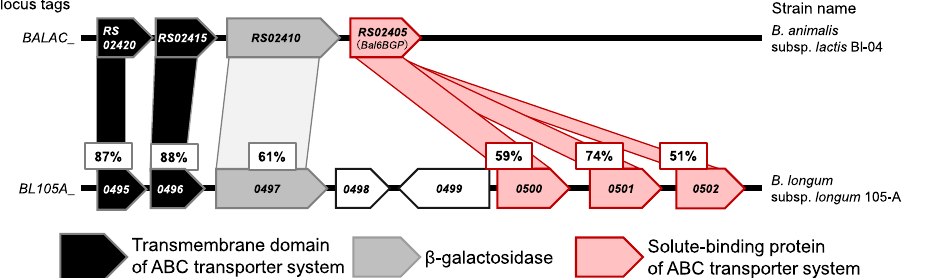
Fig. 1 Comparison of the genomic structure of B. animalis subsp. lactis Bl-04 at the Bal6 BGP locus with the corresponding region of B. longum subsp. longum 105-A. Solid arrows indicate open reading frames (ORFs) with their lengths proportional to the polypeptide chain lengths. The locus tag numbers are indicated inside the arrows. The amino acid identity (%) between the homologues is shown. The genes coding for transmembrane component, β -galactosidase, and SBP are coloured in black, grey, and light red,